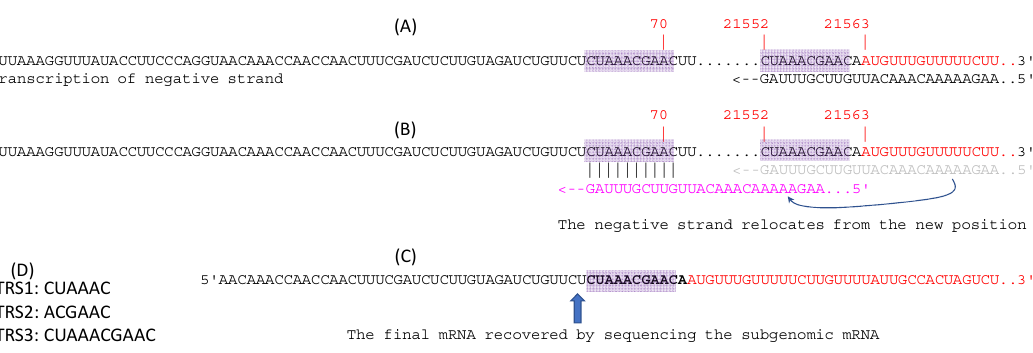
Figure 4. Discontinuous transcription of subgenomic SARS-2-S mRNA. ( A ) SARS-CoV-2 genome (NC_045512) with the leader sequence at sites 1–70, and two shaded transcription regulatory sequence (TRS), with TRS-L at the end of the leader sequence and TRS-B upstream of the coding sequence for the spike protein colored in red. The transcription of the negative strand progresses up to TRS-B and pauses. ( B ) The negative strand shifts location from base-pairing with TRS-B to base-pairing with TRS-L. Transcription of the negative strand continues. ( C ) SARS-2-S mRNA transcribed from the negative subgenomic strand. ( D ) Three frequently used TRS in coronavirus, with the first two likely being degenerate forms of the third.